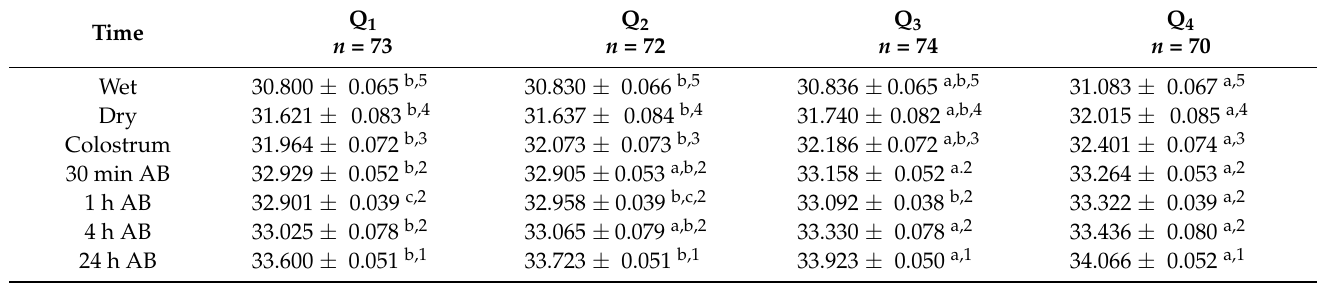
Table 1. Average of the temperature of upper left palpebral (ULP) window at different times in newborn puppies classified into 4 groups according to